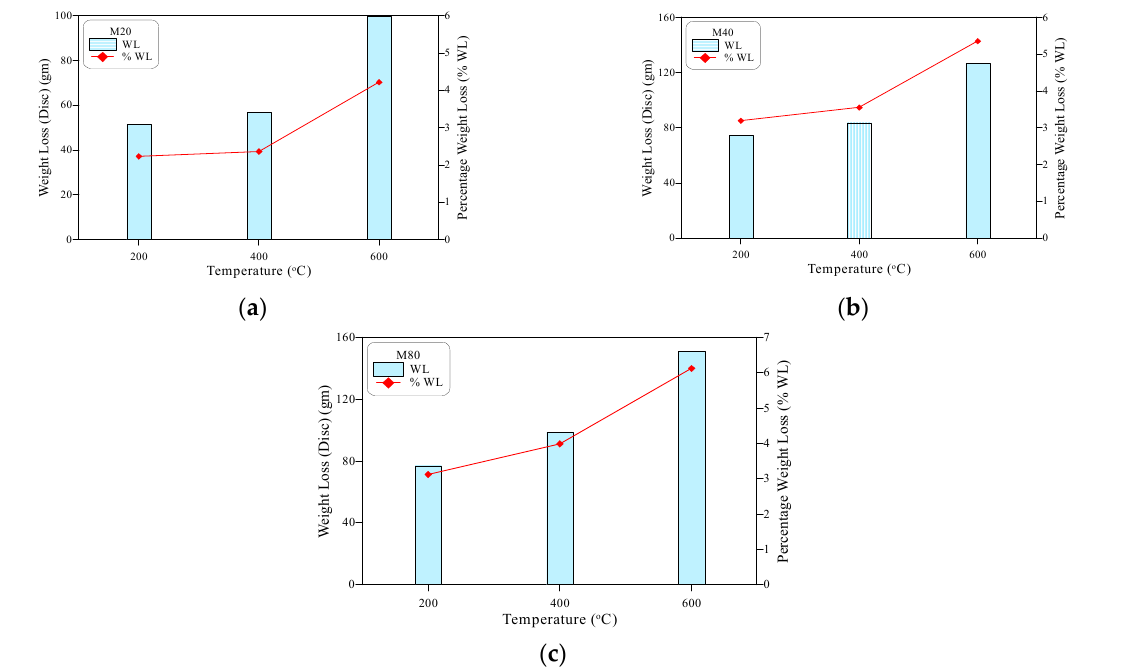
Figure 9. Weight loss of the heated cylinders: ( a ) M20, ( b ) M40, ( c ) M80.